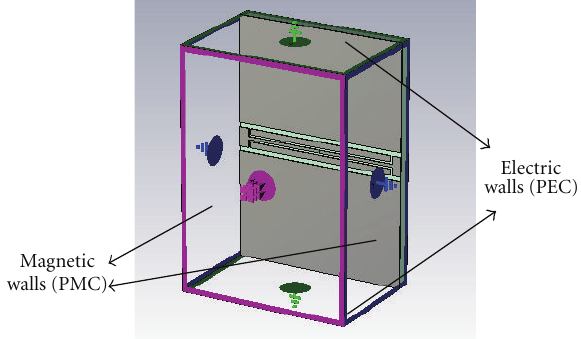
Figure 4: Boundary conditions enforced for application of FIT. A perfect magnetic conductor (PMC) was assumed on the side walls where the input and output ports intersect the feeding CPW (marked by blue ground symbols); perfect electrically conducting (PEC) walls were assumed on the top and bottom faces (marked by green ground symbols).